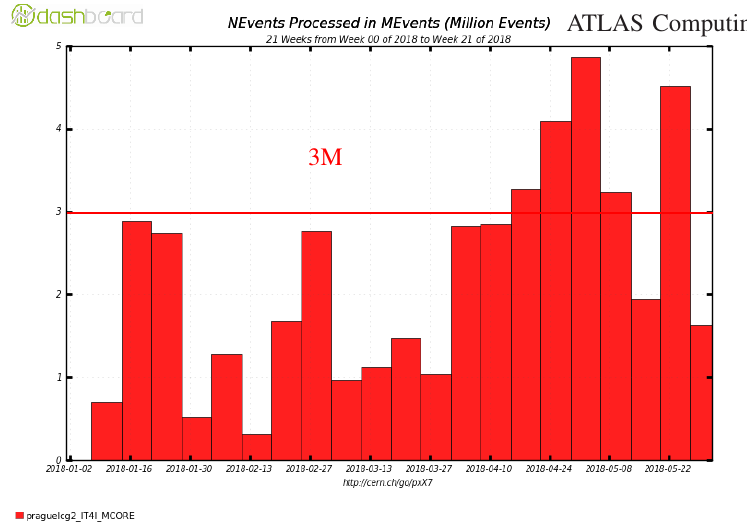
Figure 5. Number of events processed every